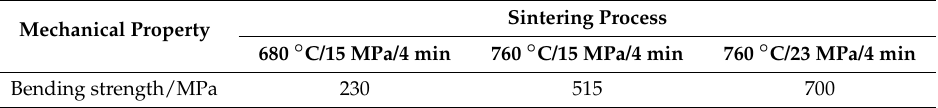
Table 1. Bending strength of Fe-Based impregnated diamond segments.